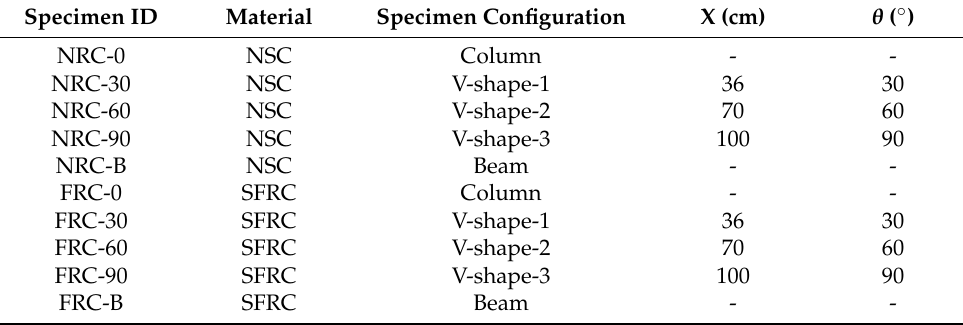
Table 1. Specimen